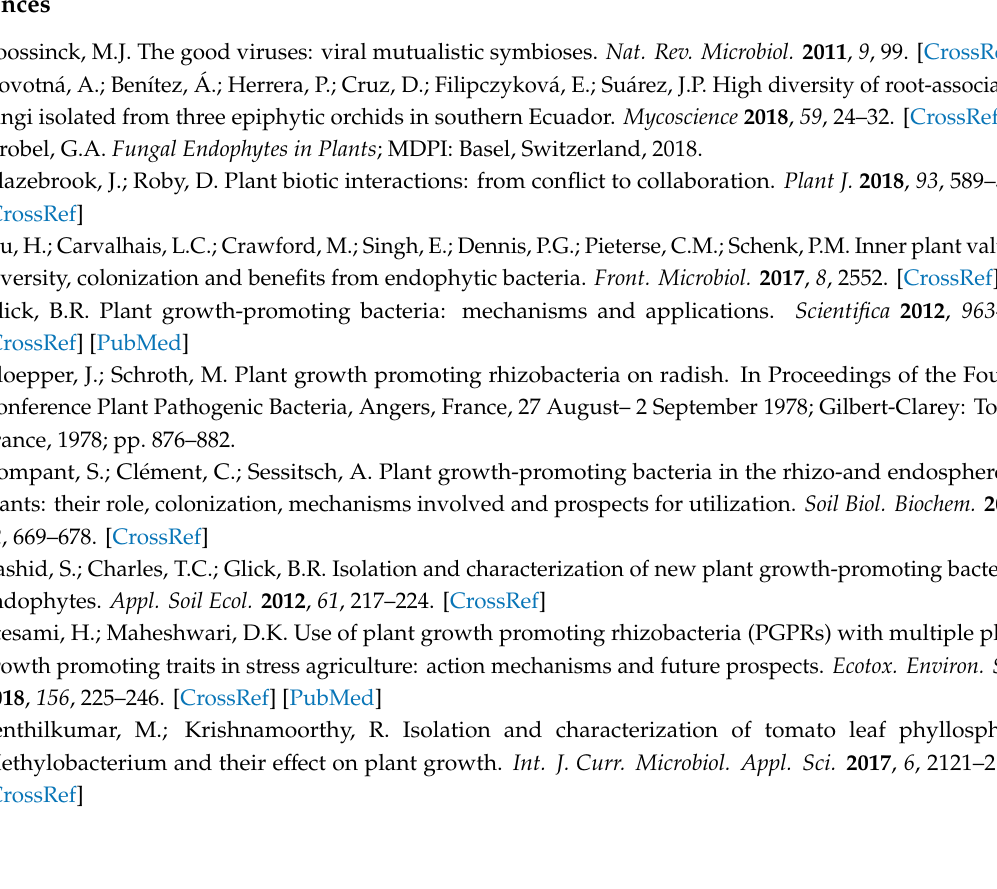
Table S1: Isolation frequency and plant growth promoting traits of the bacterial strains obtained from the peloton-containing root slices, Table S2: Assessment of the inhibition potential of the isolated bacterial strains on the growth of potential plant fungal